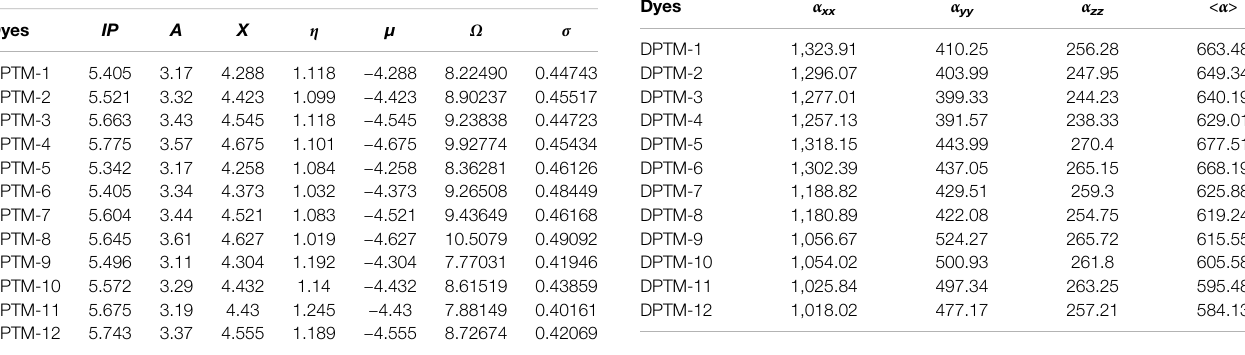
TABLE 2 | Ionization potential ( IP ), electron af fi nity ( A ), electronegativity ( X ), global hardness ( η ), chemical potential ( μ ), global electrophilicity ( ω ), and global softness ( σ ) of entitled compounds (DPTM-1 to DPTM-12 )